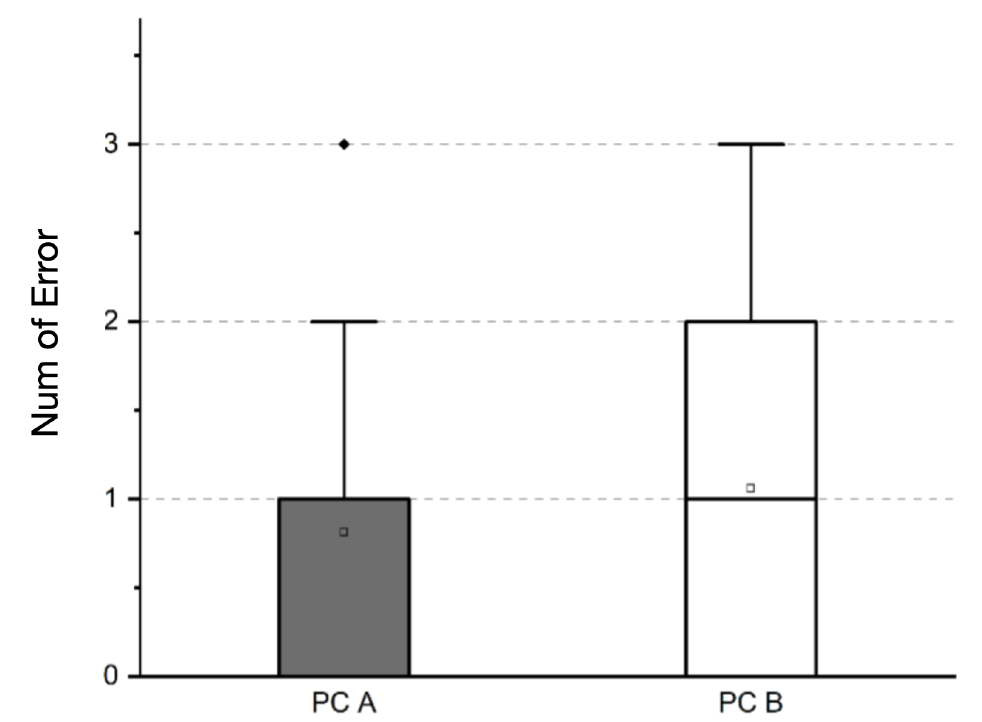
Figure 37. Mean number of errors during the implementation in PC assembly